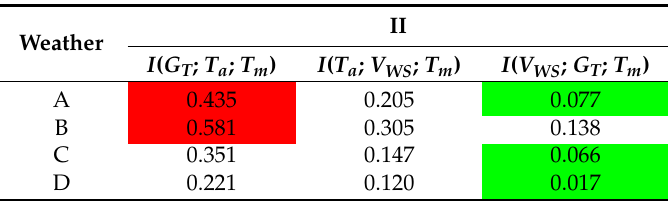
Table 11. The interaction information (II) in four GWCs. The highest values are in red boxes and the